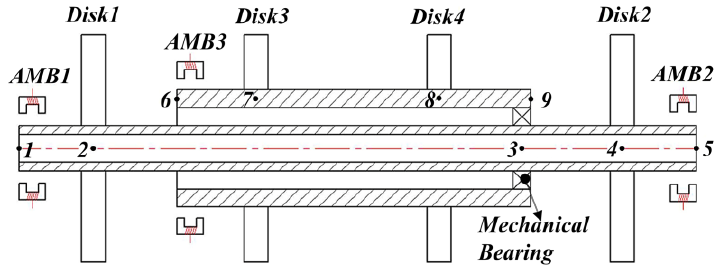
Figure 1. Finite element model of the MSDS. Table 1. The main parameters of the MSDS..